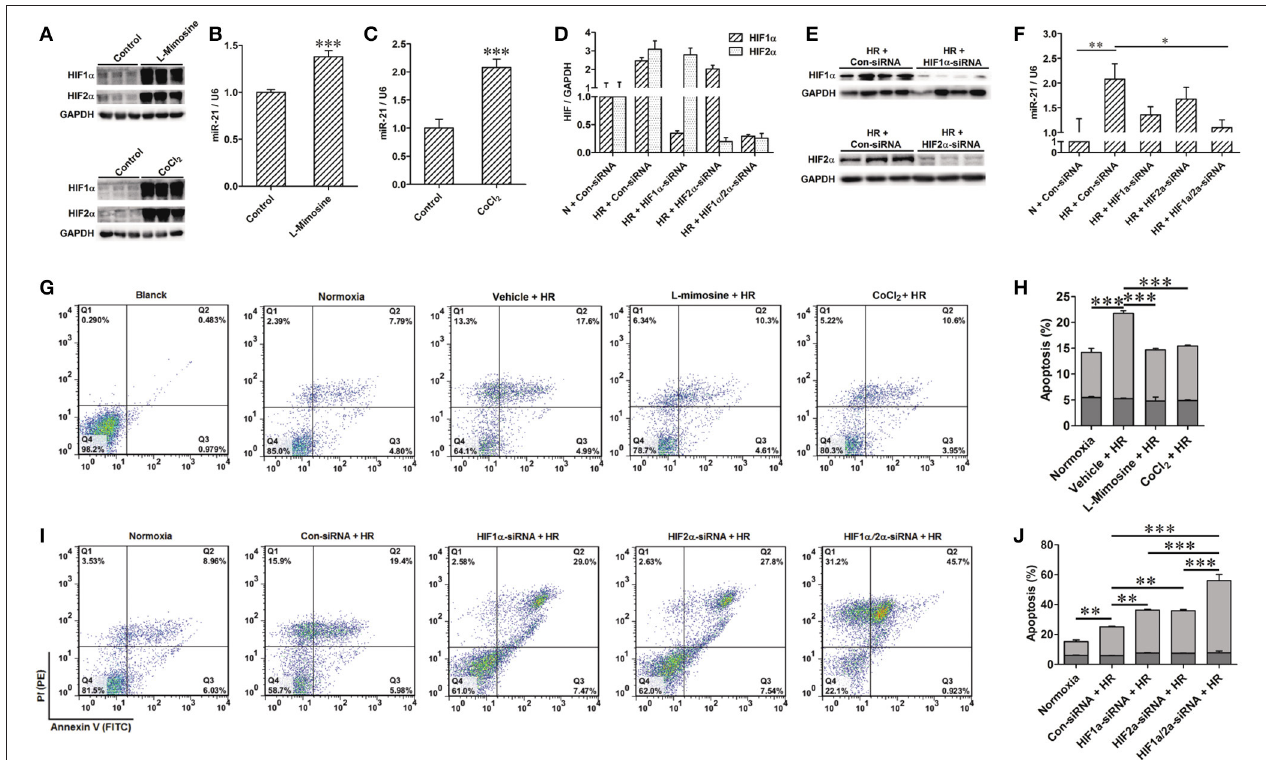
FIGURE 5 | Activation of HIF protected HK-2 injury by mediating miR-21. (A–C) Hydrolysis of HIF was inhibited by 500 µ M L-Mimosine or 150 µ M CoCl 2 . Elevated expression of HIF increased expression of miR-21. (D,E) Interfered expression of HIF1 α and/or 2 α by transfected with HIF1 α and/or 2 α siRNA to HK-2 cells under hypoxia/reoxygenation and normoxic conditions was confirmed by qRT-PCR and western blotting. (F) Interference expression of HIF1 α and/or 2 α modulated elevated expression of miR-21 induced by HR. (G) Apoptosis of the HK-2 cells was accessed by annexin-V-FITC/PI staining and determined by flow cytometry. Treatment of HK-2 cells with L-Mimosine or CoCl 2 attenuated HR induced apoptosis. (H) Group data from (E) . (I) HR increased late apoptosis of HK-2 cells, after inhibiting HIF1 α and/or 2 α , the effect of HR on apoptosis was enhanced. (J) Group data from I. * P < 0.05, ** P < 0.01, *** < 0.001, n = 3 for flow cytometry, n = 6 for